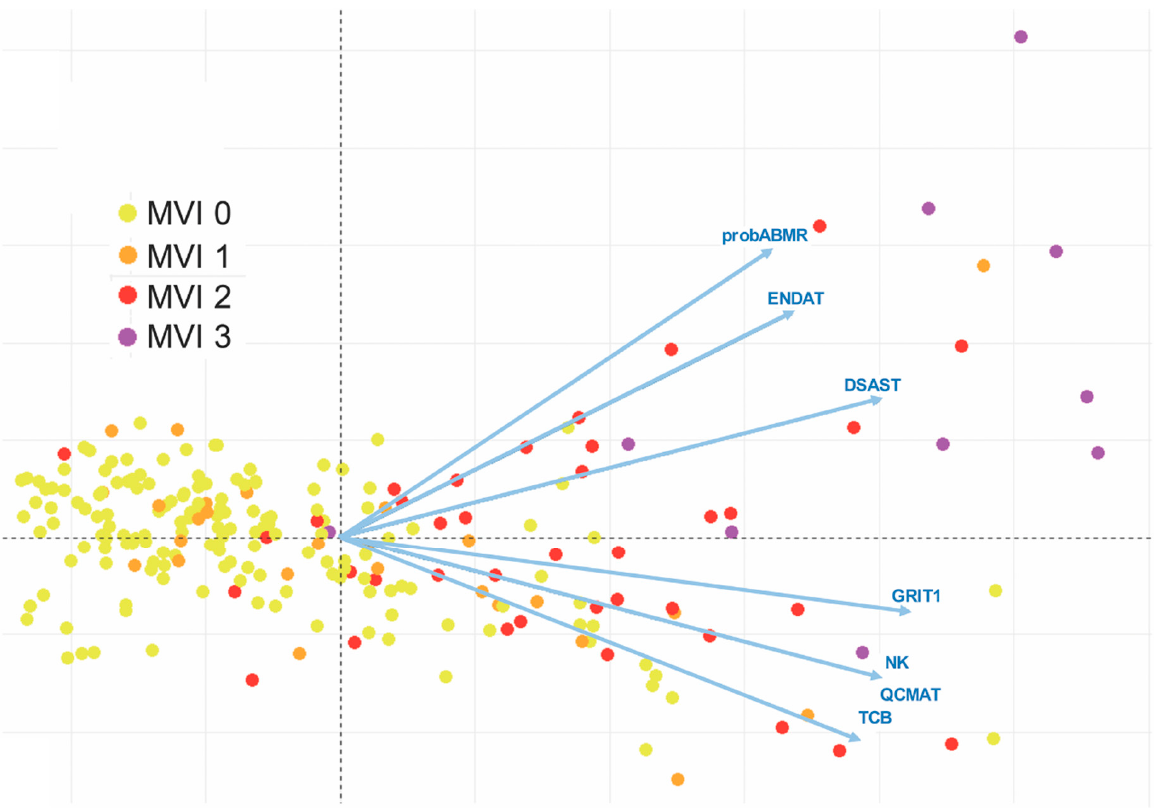
Figure 2. Correlation of molecular profiles with the microvascular inflammation (MVI) score—microarray analysis. Unsupervised principal component analysis (PCA) of MVI based on molecular profiles. Each dot represents one of the 182 endomyocardial biopsies (EMB) used for the microarray analysis, which are colored according to their MVI scores and distributed by their molecular features, as determined by the PCA. The PCA was based on six pathogenesis-based transcripts (DSAST: Donor-specific antibody transcripts; ENDAT: Endothelial transcripts; GRIT1: Interferon-gamma transcripts; NK: Infiltration of natural killer cells; QCMAT: Infiltration of macrophages; TCB: Infiltration of T cells), and one classifier score (probABMR). The extent of MVI was graded semi-quantitatively according to the percentage of myocardial area with MVI: MVI 0 represents 0% (negative MVI); MVI 1 is 1–10% (minimal MVI); MVI 2 is 11–50% (focal MVI); and MVI 3 represents > 50% (diffuse MVI). Areas of previous biopsy, replacement fibrosis, foci of ischemia, quilty lesions, and sites in close contact with foci of cellular rejection were excluded for the evaluation of MVI.